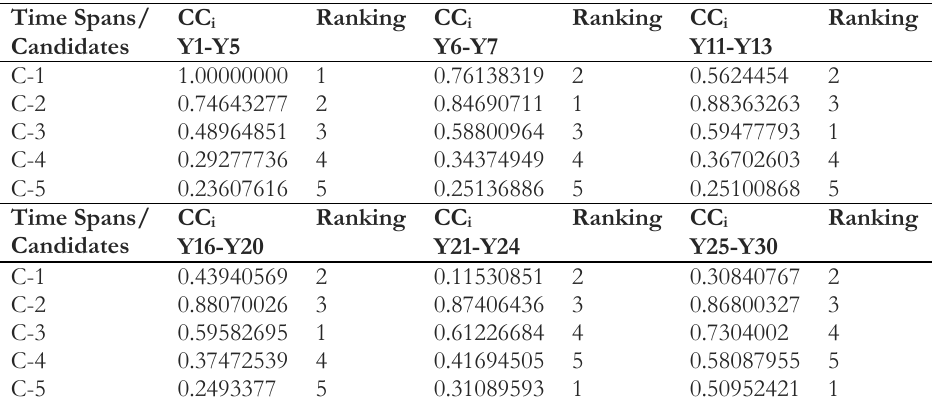
Table 13. The similarity coefficients (CCi) and the ranking of the candidates according to the worst similarity for different time spans.